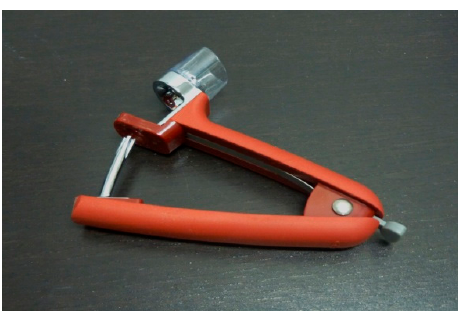
Figure A4. Cherry pitter.